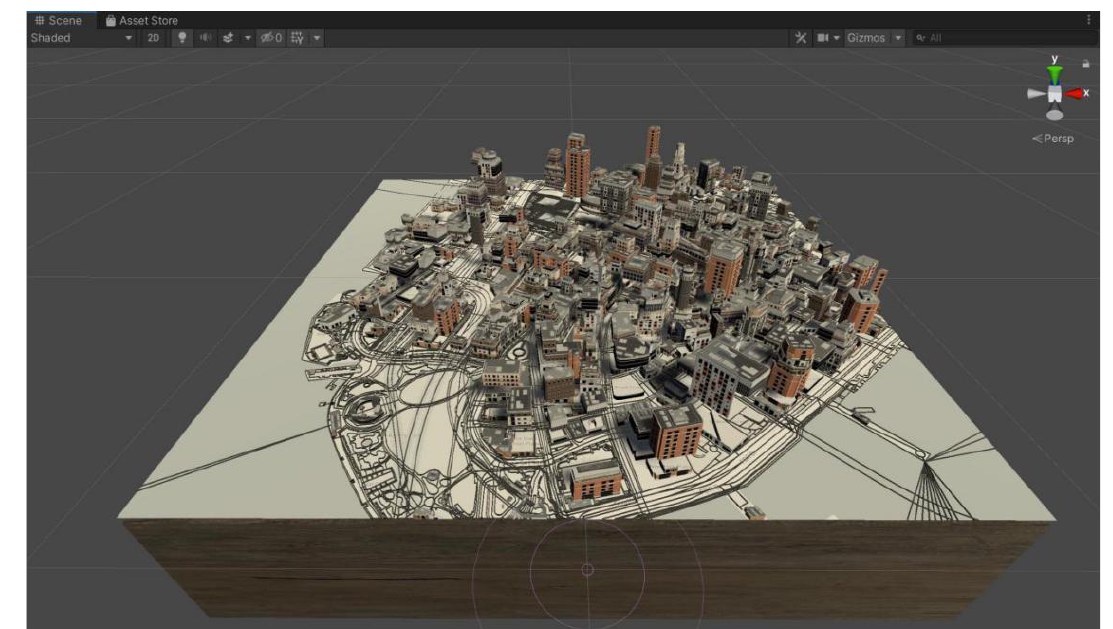
Figure 1. The virtual scene of experiment 1.